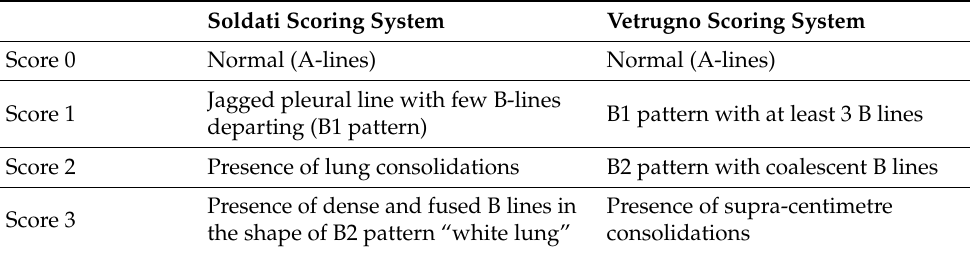
Table 1. Scoring systems for lung ultrasound by Soldati et al. and Vetrugno et al.